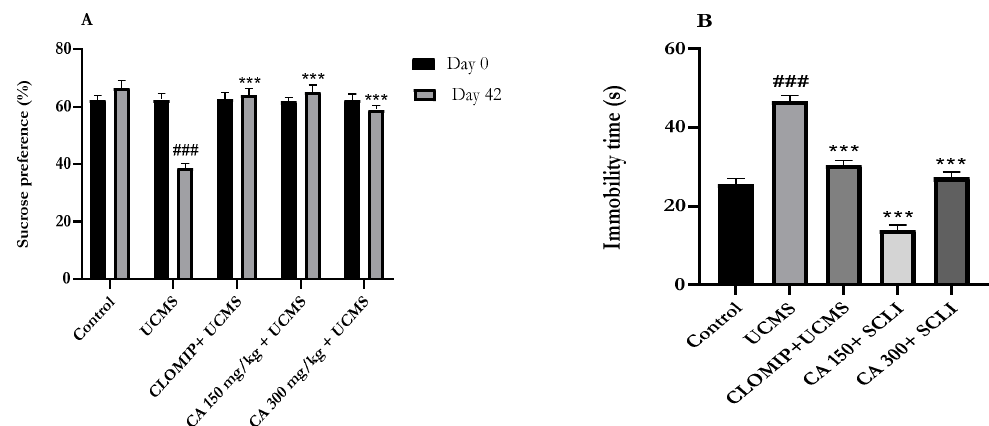
Figure 2. Effect of DCM/MeOH extract of C. adansonii on sucrose preference (A) and immobility time in the FST (B) of mice before and after 30 days of treatment Each bar represents the mean ± MSE, UCMS: chronic mild unpredictable stress; CLOMIP + UCMS: positive control receiving clomipramine (20 mg/kg); CA + UCMS: animals receiving the DCM/MeOH mixture extract (v/v: 1/1) of C. adansonii at doses of 150 and 300 mg/kg. *** p < 0.001 compared to UCMS group. ### p < 0.001 compared to the normal